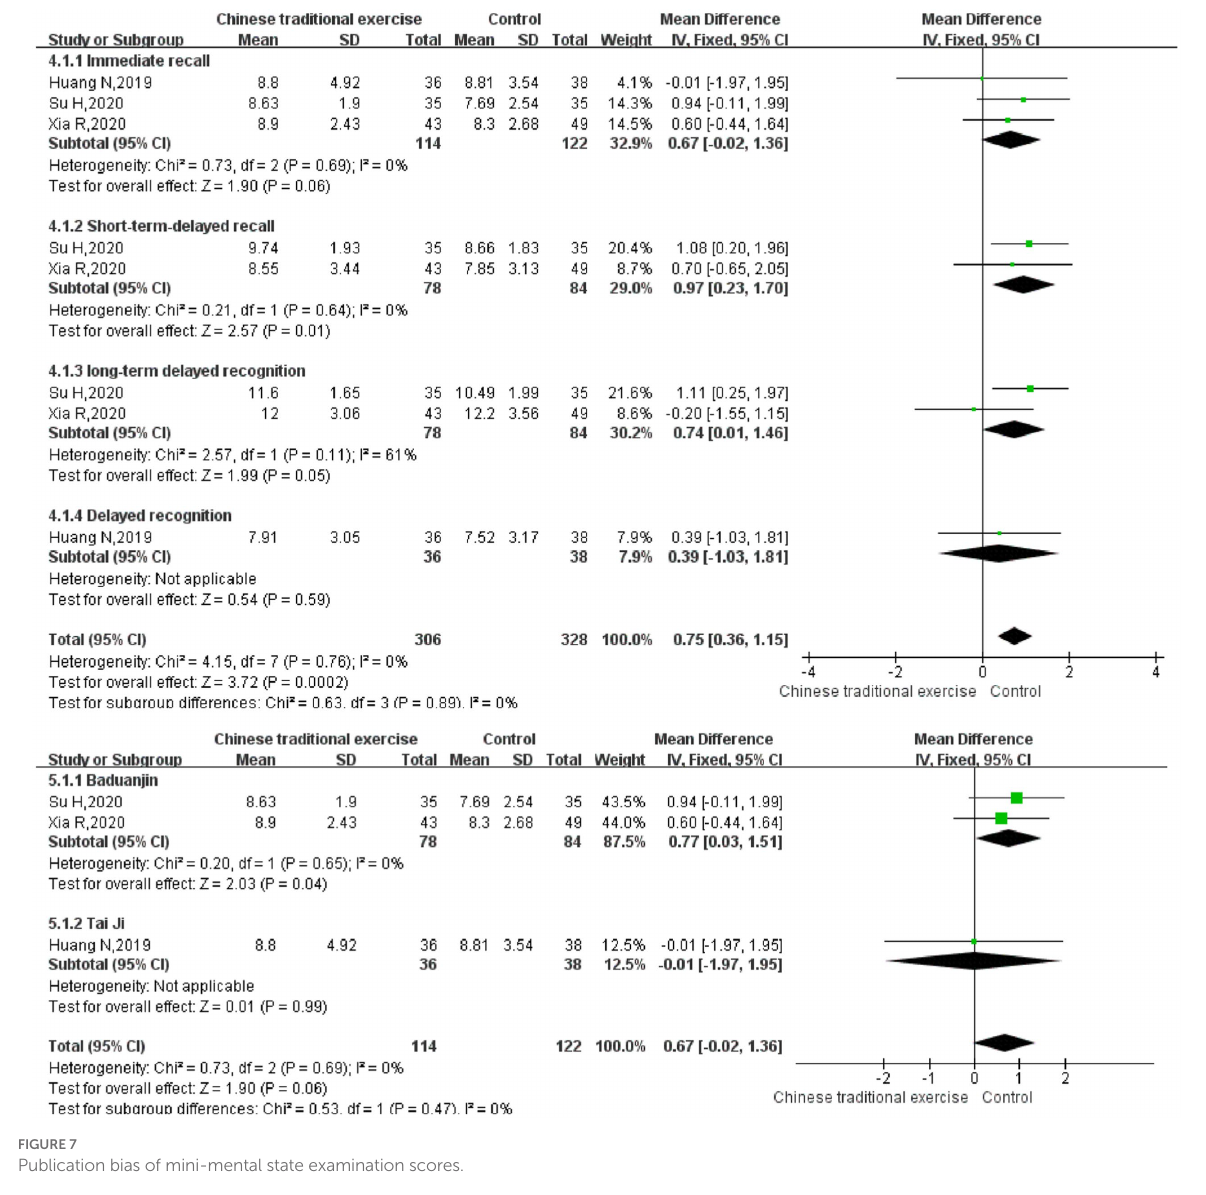
FIGURE 7 Publication bias of mini-mental state examination scores.